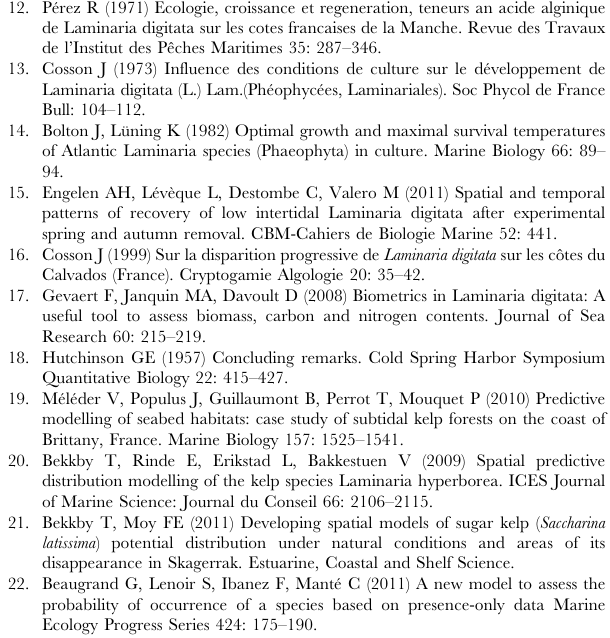
Figure S1 Distribution map of the occurrence data points of Laminaria digitata along European coasts from two datasets (OBIS and EcoKelp) and from the examination of the literature. Figure S2 Modeled ecological niche of Laminaria digi- tata assessed from NPPEN and based on three environ- mental factors represented by pairs. a, Maximum annual SST and bathymetry; b, Maximum annual SST and salinity; c, Bathymetry and salinity. The colorbar indicates the probability of occurrence of L. digitata . Figure S3 Comparisons between observed and two modeled SSTs (MPI-ESM-LR and CRNM-CM5) for the period 2006–2009 and three climate scenarios (RCP2.6, RCP4.5 and RCP8.5). The comparison was made by means of